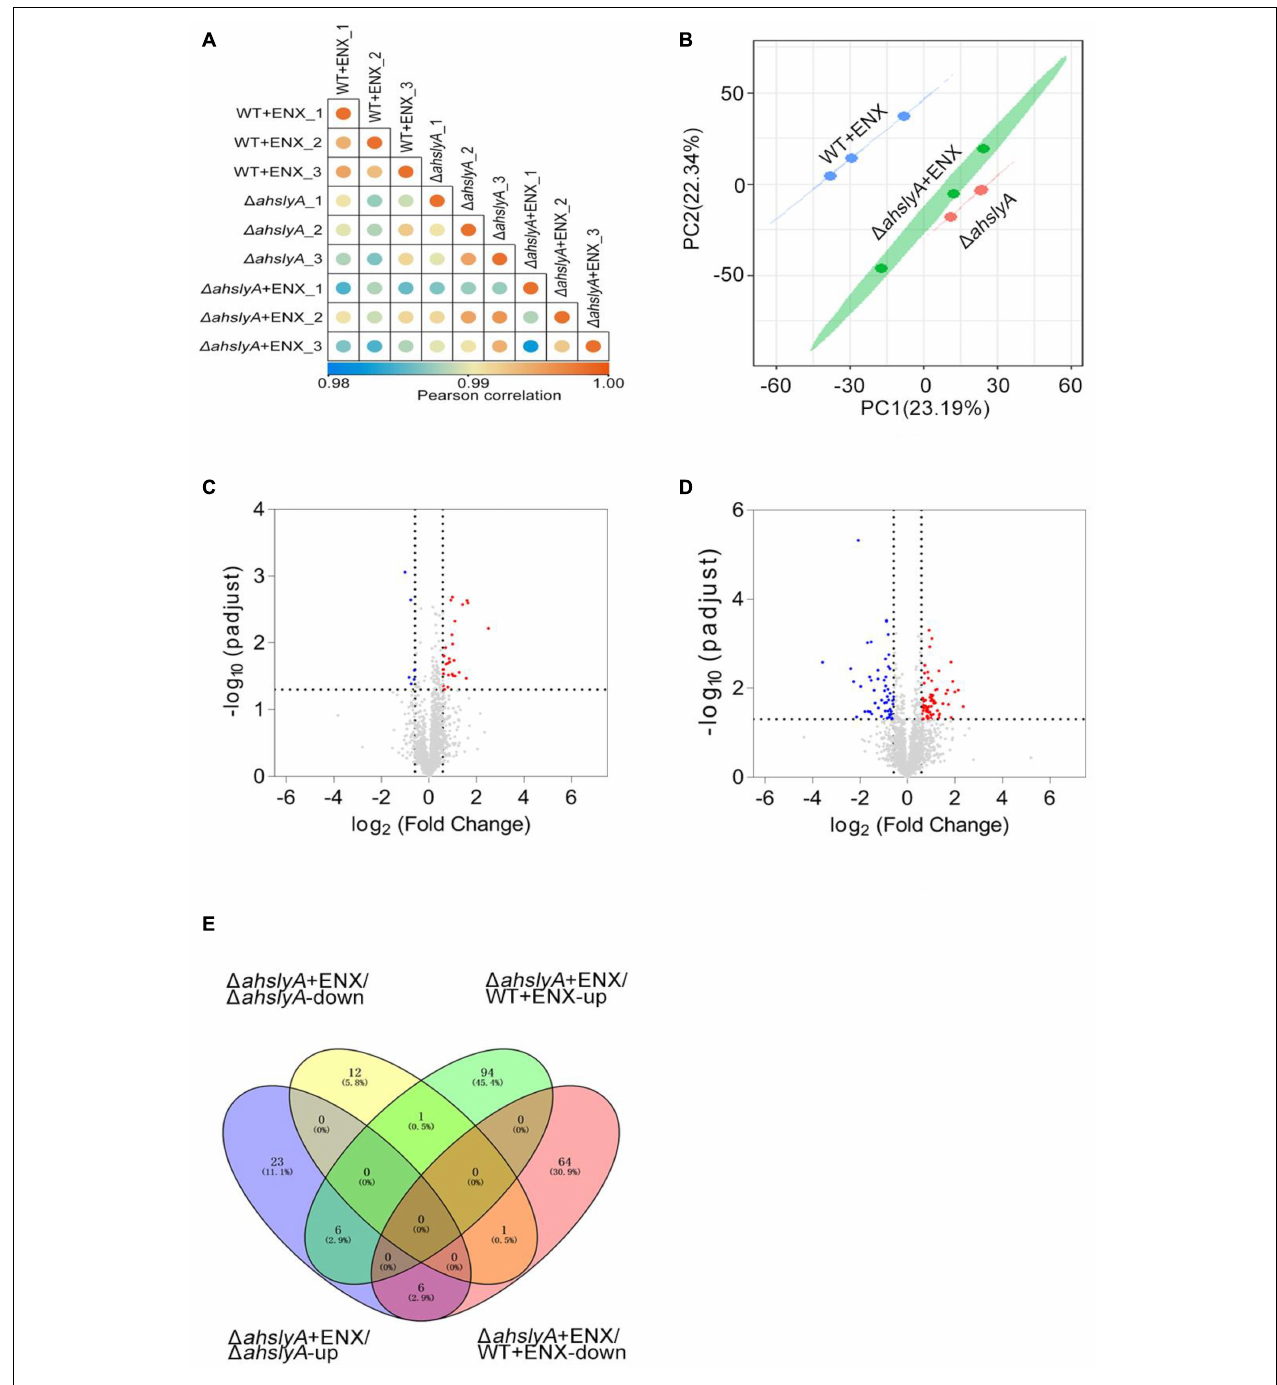
FIGURE 2 | Label-free quantitative proteomics data analysis. (A) Correlation coefficient analysis of protein MS intensity in three biological replications. (B) PCA of WT + ENX, (cid:49) ahslyA + ENX, and (cid:49) ahslyA . (C,D) Volcano maps comparing the abundance ratios of proteins with significant differences in expression between (cid:49) ahslyA + ENX vs. (cid:49) ahslyA and (cid:49) ahslyA + ENX vs. WT + ENX, respectively. The blue dots represent downregulated proteins, red dots represent upregulated proteins, and the gray color represents non-differentially expressed proteins. (E) Venn-diagram of differentially expressed proteins between two comparisons.